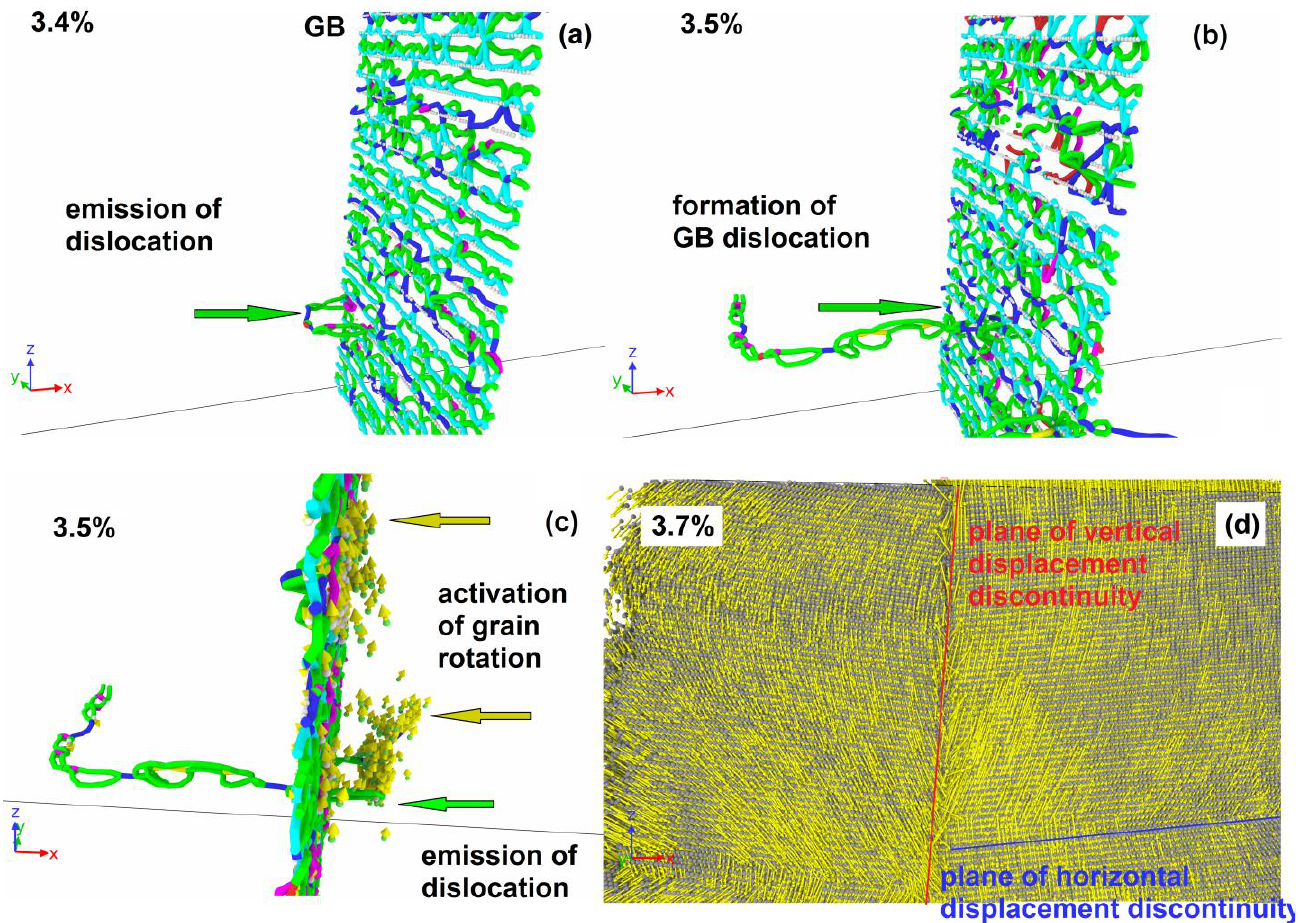
Figure 7. Deformation of system with 75% filling of one column by Cu atoms (3.85 nm − 2 ). ( a ) Emis- sion of dislocation semi-loop from GB into a grain. ( b ) Growth of dislocation semi-loop and formation of secondary dislocation loop at GB. ( c ) Emission of secondary dislocation loop into second grain and activation of grain rotation; vertically shifted atoms are shown with displacements. ( d ) Displacement vectors of atoms (yellow); in the left part of the panel, the displacements have a vertical component directed downwards, in the right part—upwards, the vertical displacements discontinuity is located between them (red line). In the right part of the system, traces of intragranular dislocation slip are visible, expressed as a discontinuity in horizontal atom displacements (blue line). Dislocation structure is determined by DXA: blue lines are perfect dislocations, green—Shockley partials, light blue—Frank partials, purple—stair rod segments.